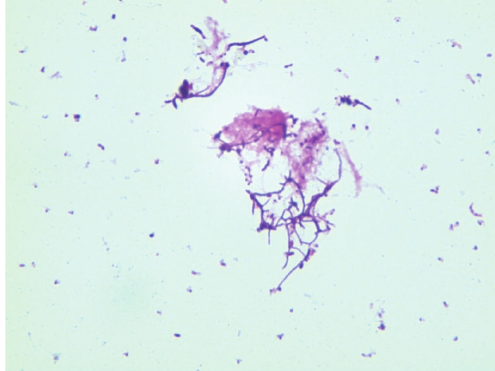
Figure 3: Photomicroscopy of the Gram stain of the aspirated fluid from the cystic masses shows the Gram-positive branching rods indicating the presence of Nocardia